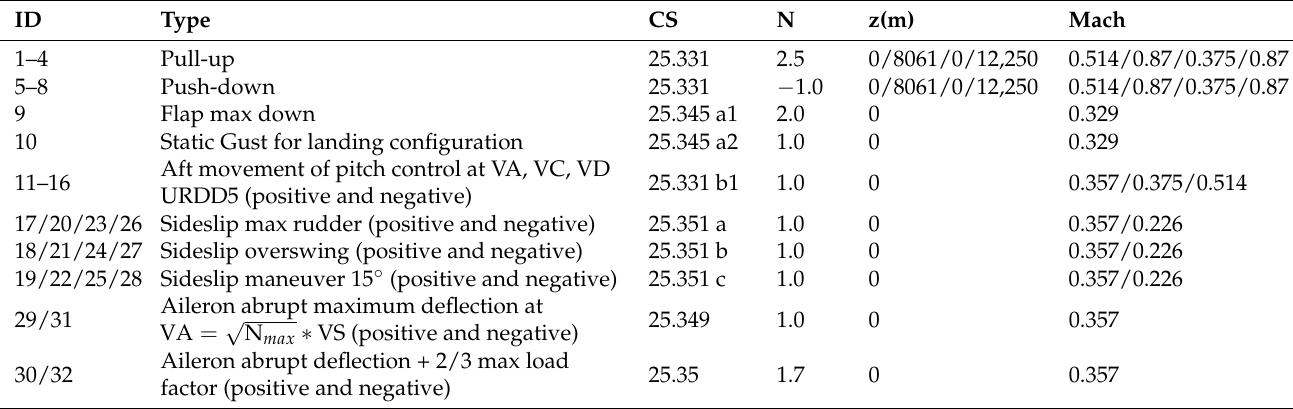
Table 4. Maneuver conditions used to size the